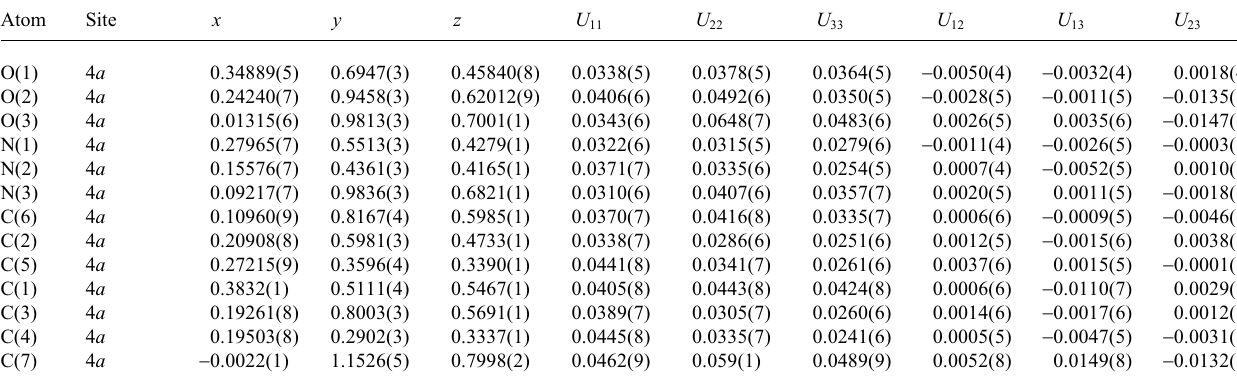
Table 3. Atomic coordinates and displacement parameters (in Å 2 ).